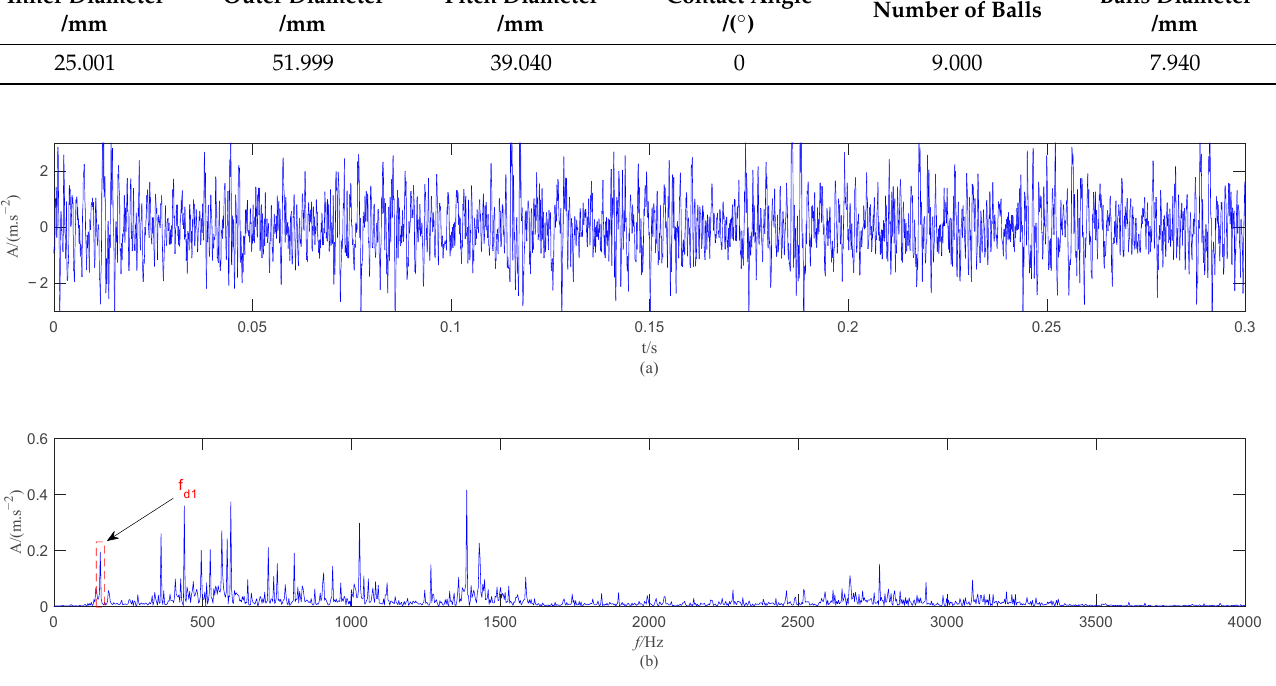
Figure 6. Original signal of SKF 6205-2RSJEM ( a ) time domain curve ( b ) frequency domain curve.